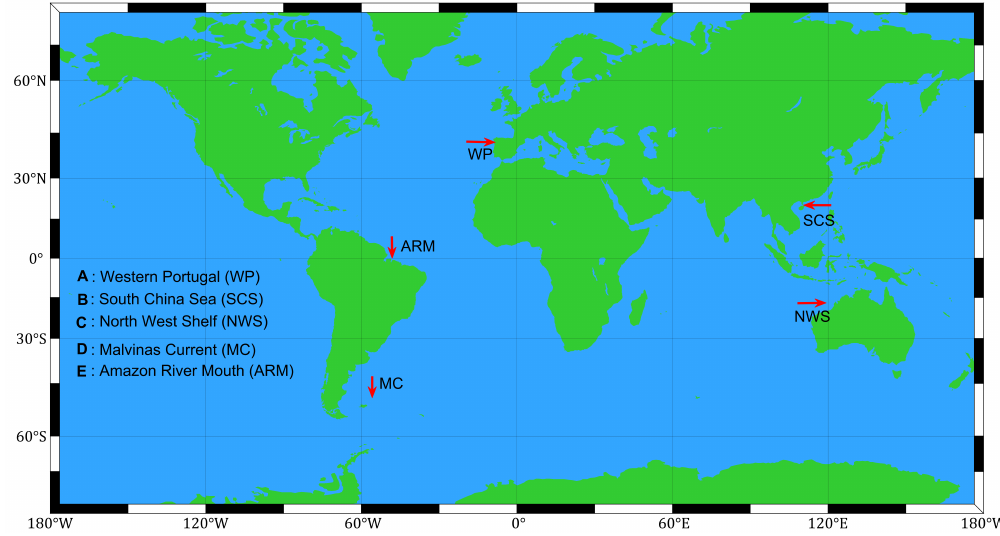
Figure 1. Five oceanic transects where internal solitary waves are known to occur